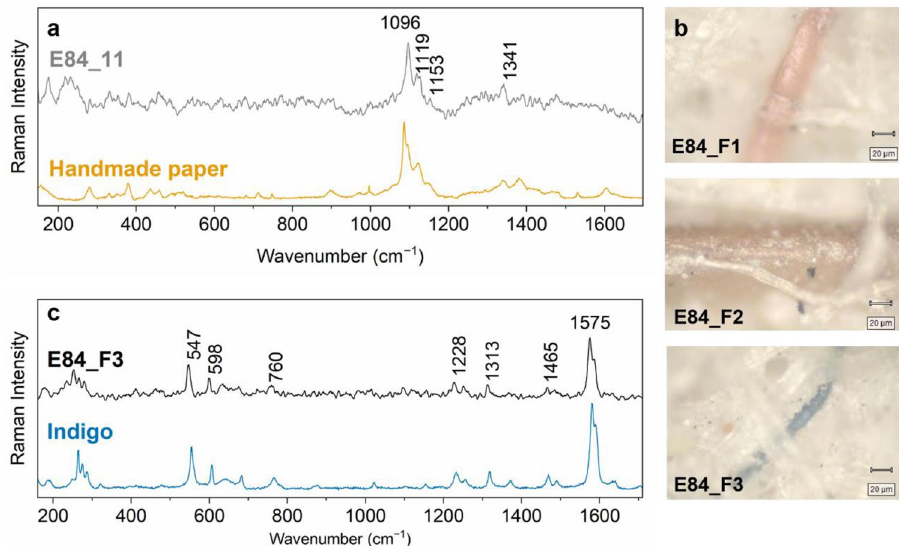
Figure 2. ( a ) μ-Raman spectrum from the paper support (E84_11) compared to the reference of handmade paper, ( b ) microphotographs of the three different fibres, ( c ) μ-Raman spectrum from the blue fibre (E84_F3) compared to indigo reference.